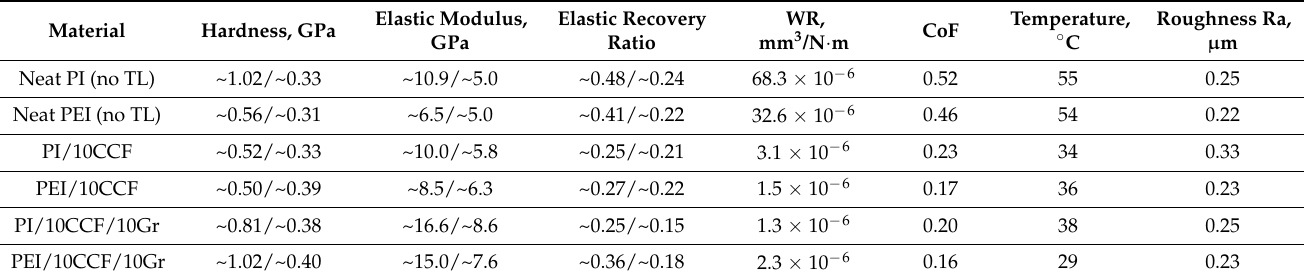
Table 4. The nanoindentation data for both neat PI and PEI, as well as their composites at the minimal/maximal load on the Berkovich